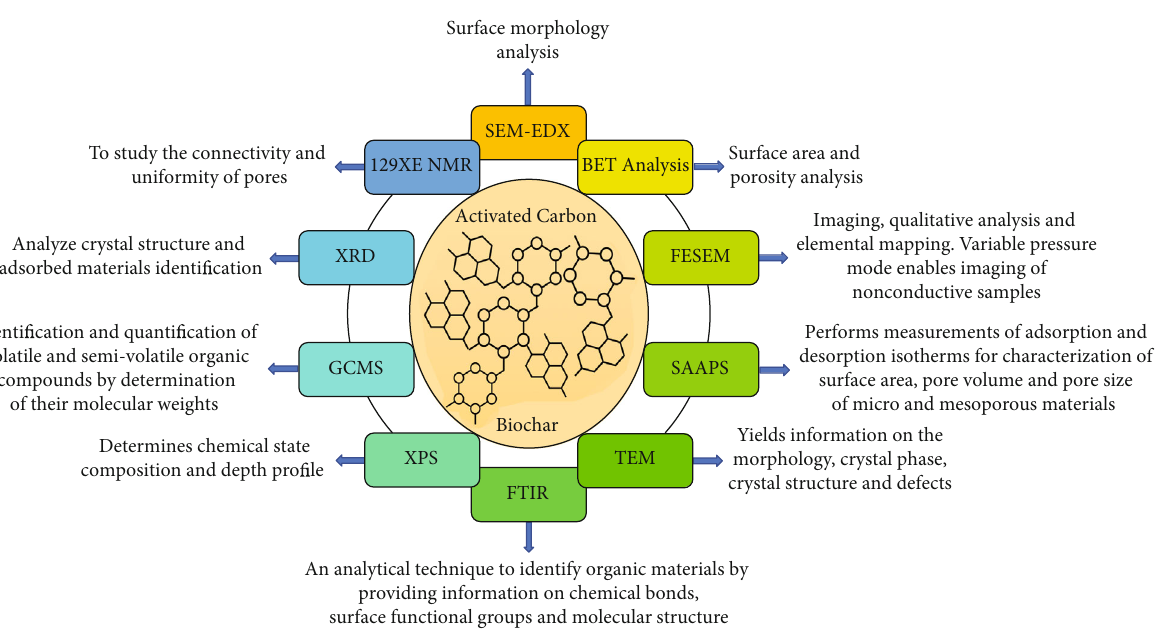
Figure 1: Characterization methods used for analysis of AC and